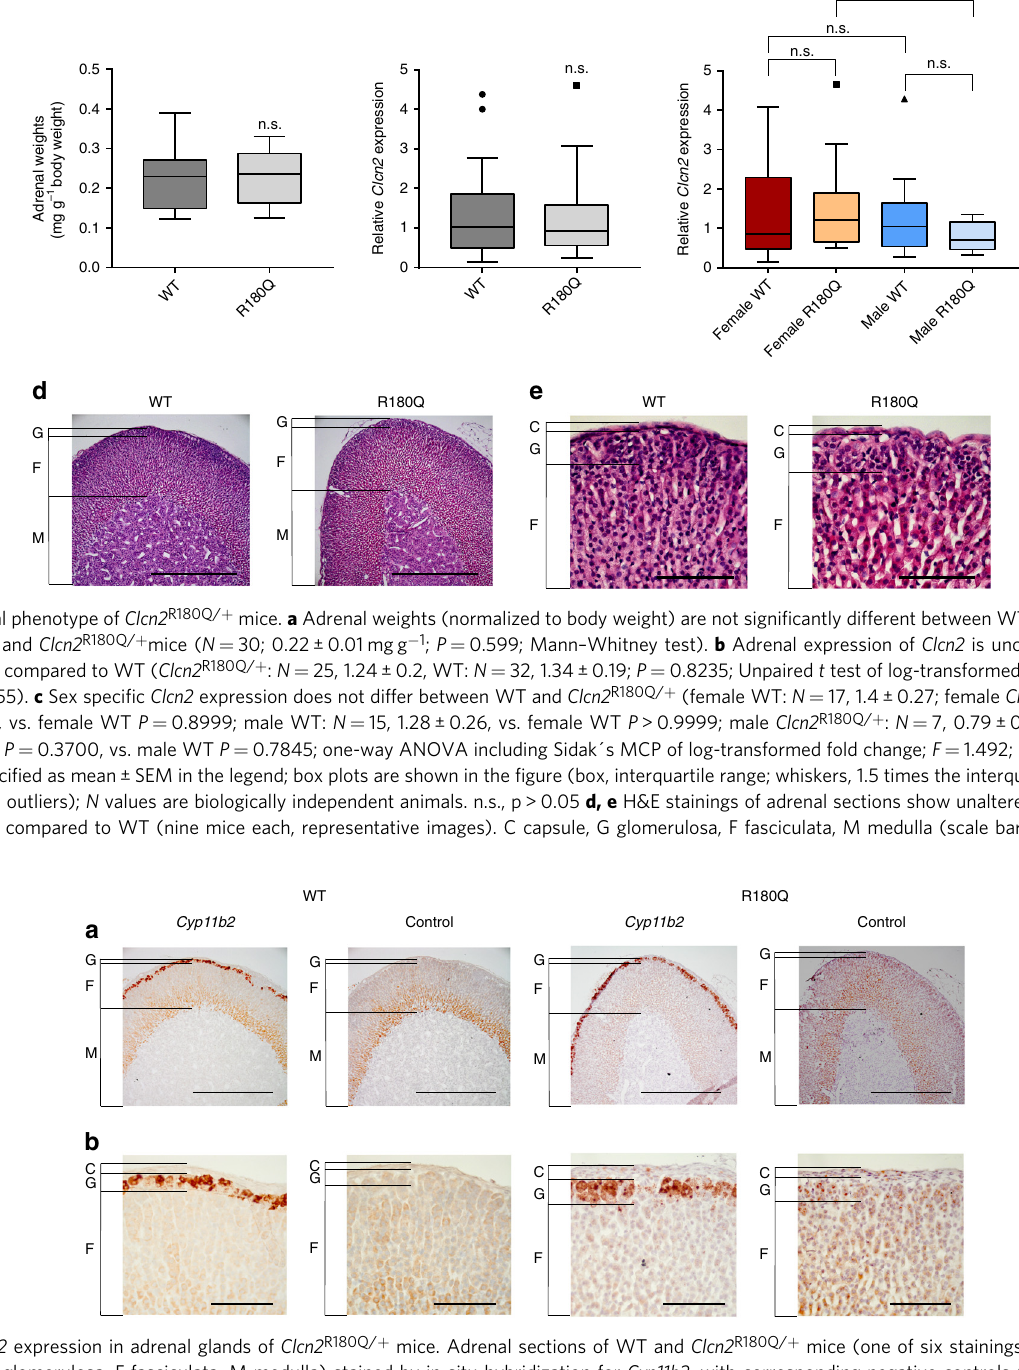
Clcn2 R180Q/ + mice have slightly elevated blood pressure . To assess whether Clcn2 R180Q/ + mice develop hypertension, we measured blood pressure of unanaesthetized 3-month-old male mice by telemetry, using catheters implanted in the carotid artery (see Methods). Systolic and diastolic blood pressures as well as mean arterial pressure (MAP) of Clcn2 R180Q/ + mice were slightly but signi fi cantly increased when compared to WT